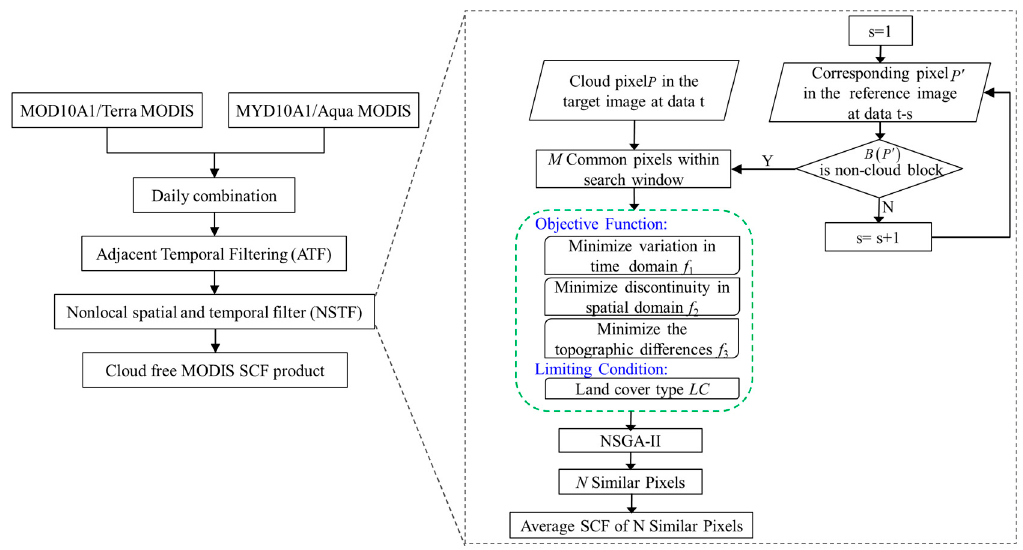
Figure 3. Schematic of the MODIS fractional snow cover (SCF) products gap-filling procedure. 1.